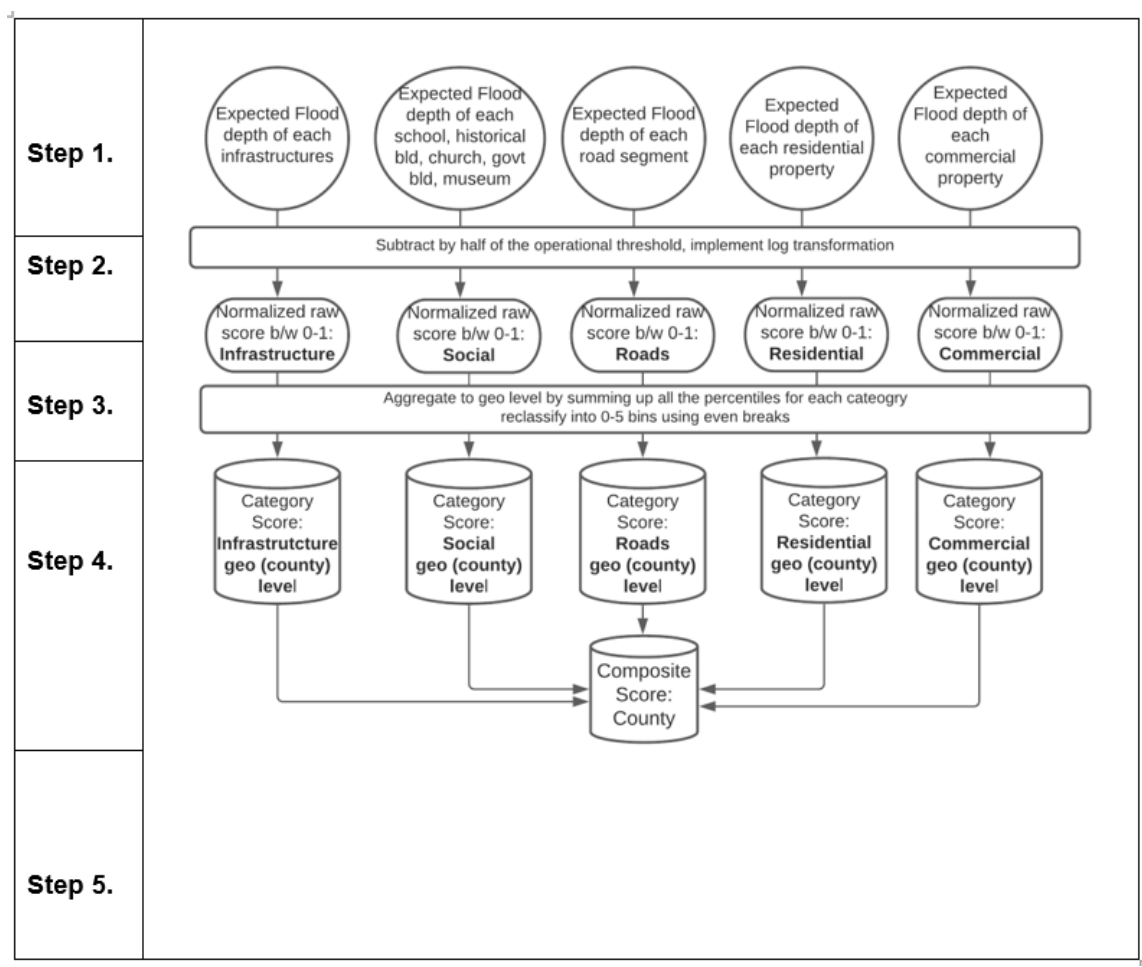
Figure 1. Data processing workflow.